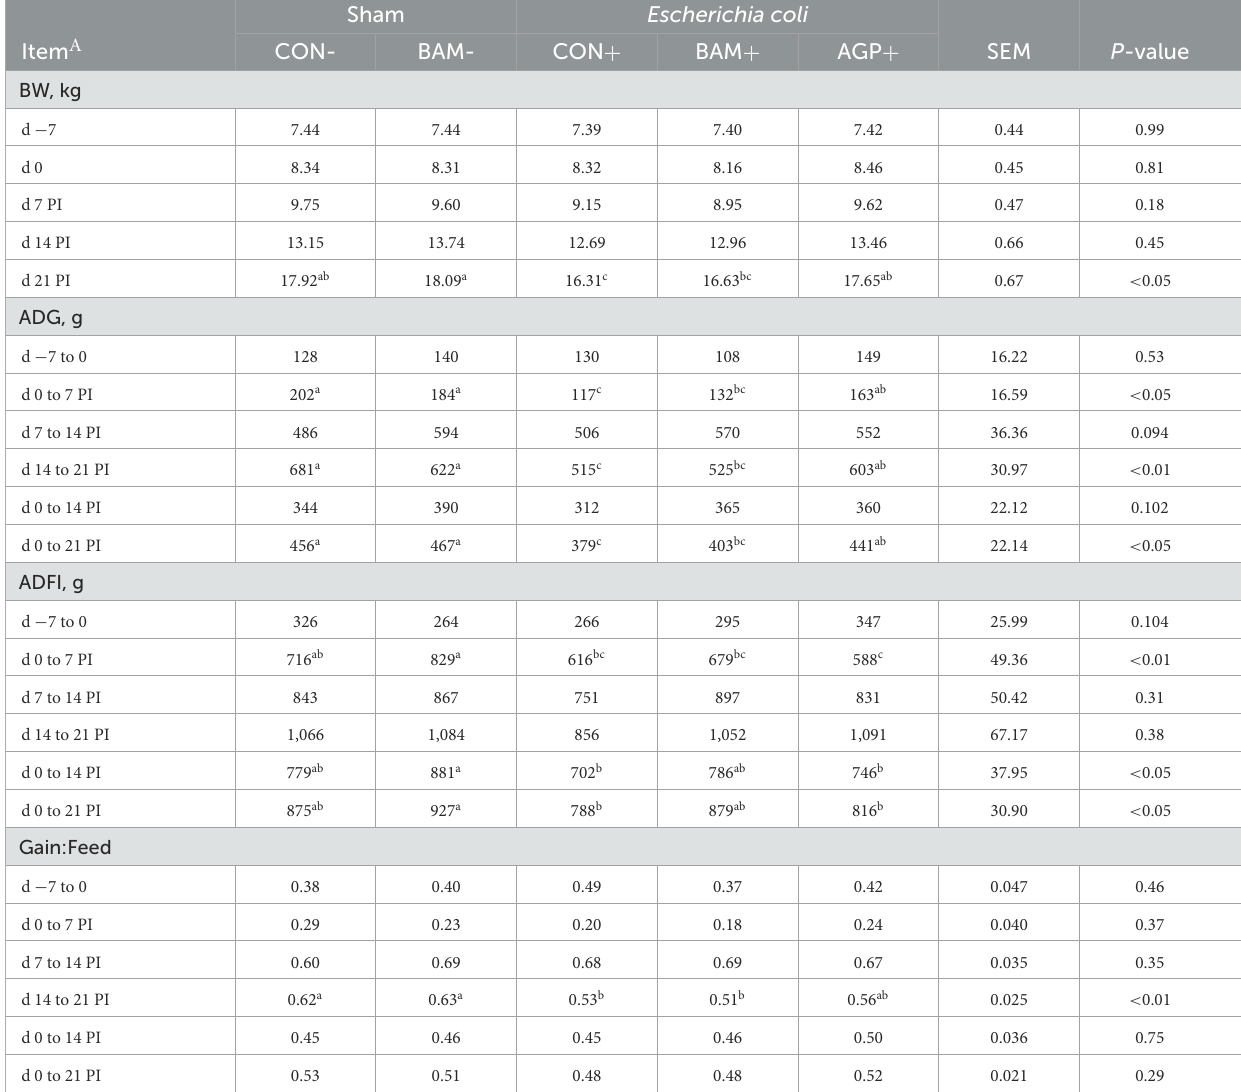
TABLE 2 Growth performance of weaned pigs fed a control (CON) diet or diets supplemented with Bacillus amyloliquefaciens (BAM) or antibiotics (AGP).